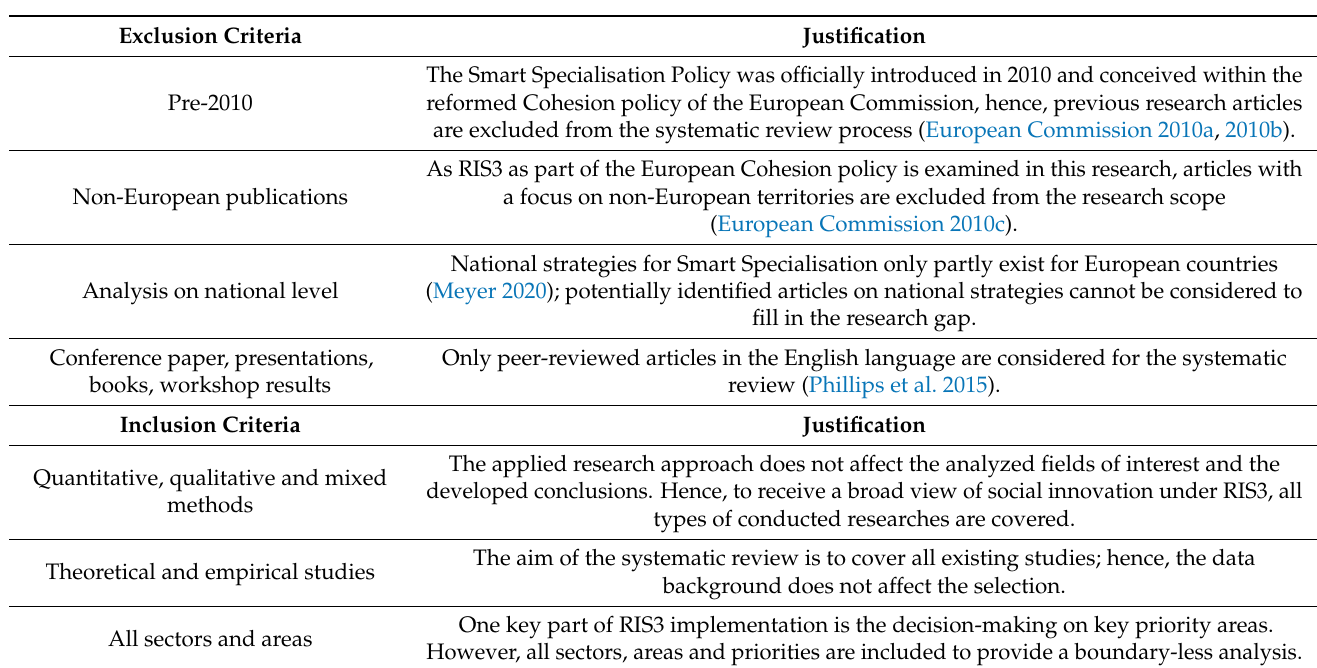
Table 1. Exclusion and inclusion criteria.